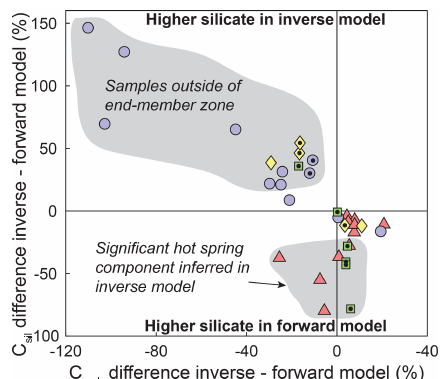
Figure A3. Difference between forward and inverse unmixing ap- proaches. Positive values indicate that the inverse approach predicts higher cation ratios than the forward approach. All samples in the upper left quadrant are outside the carbonate–silicate–hot spring– precipitation end-member space in Na + / Ca 2 + –Mg 2 + / Ca 2 + space (Fig. 3c). Samples with lower inverse silicate cation concentrations are characterized by a 3%–47% hot spring contribution that is not accounted for in the forward model (see text). Catchments underlain by different lithologies are distinguished by symbols and color. Data points with a black dot are metamorphosed to greenschist facies or